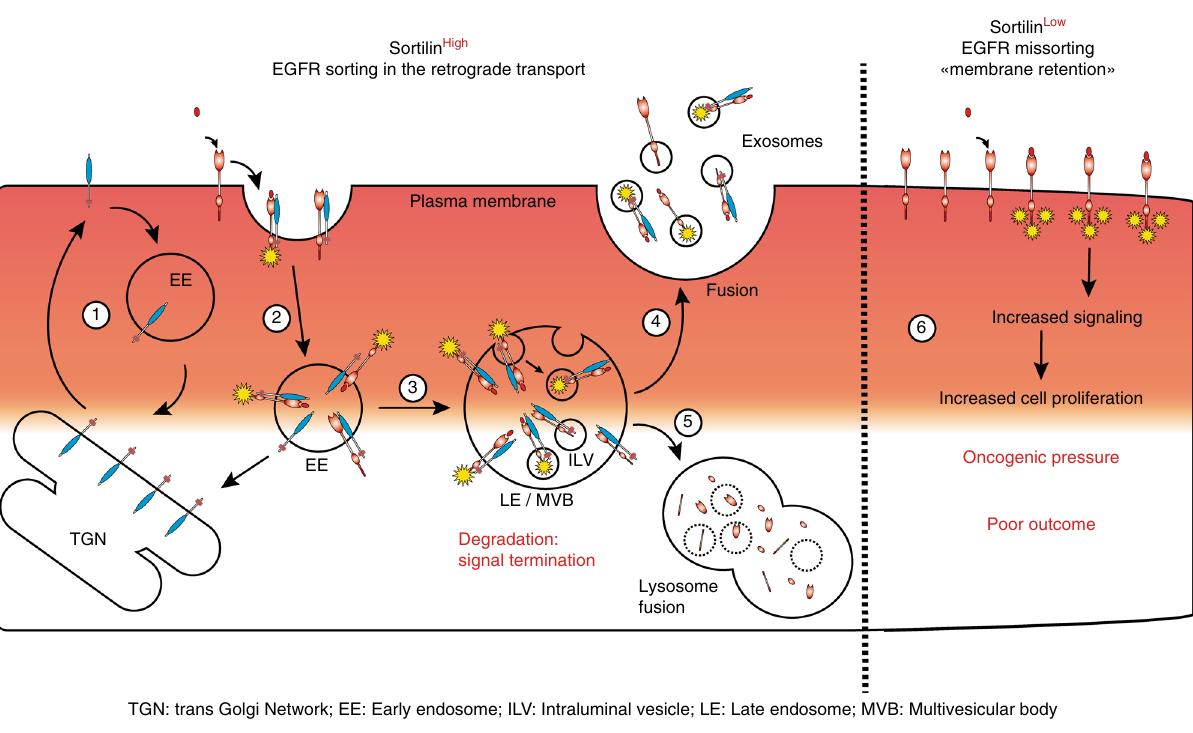
Fig. 7 Model of sortilin function in regulation of EGFR at the cell surface Representative scheme in which sortilin acts as a key regulator of EGFR retrograde transport. Sortilin is mainly localized at the trans-Golgi network (TGN), and the plasma membrane fraction of sortilin cycles continually between the cell surface and the TGN via the endosomes (1). Sortilin binds both unstimulated and stimulated EGFR to allow their internalization (2). Thus, EGFR undergoes intracellular traf fi cking and sortilin mediates its loading in intraluminal vesicles (3). This ultimately results either in EGFR release through exosomes (4) or receptor degradation (5), thus ensuring signal termination. Conversely, sortilin downregulation impairs EGFR internalization (6), and EGFR consequently retained at the cell surface. Moreover, in sortilin-downregulated cells, EGFR exists in a hyperphosphorylated state, and transduces a constitutive survival signal that promotes tumor